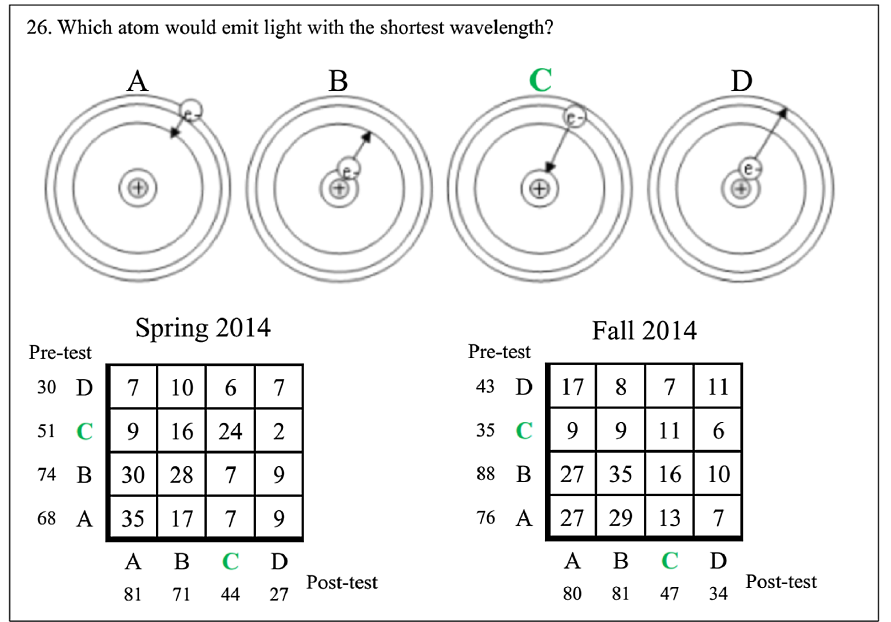
FIG. 7. Comparison of how students responded to TOAST question #26 on the pre- and post-test. Question adapted from Ref.